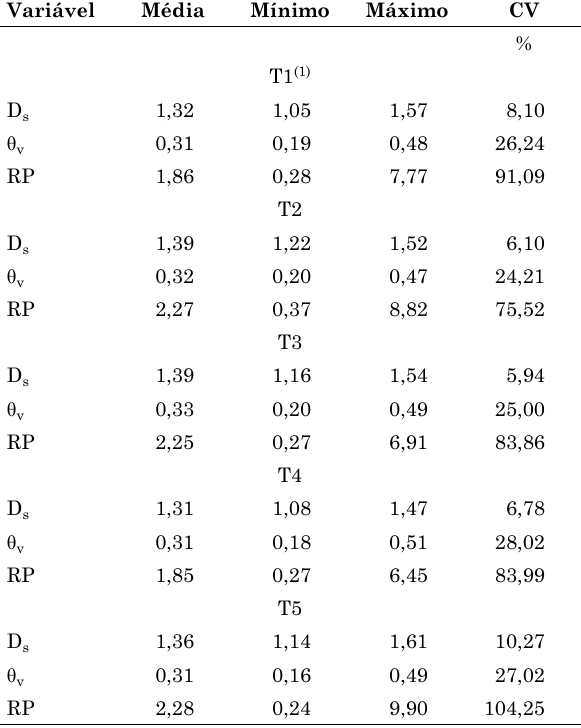
N: 56; Ds: densidade do solo (kg dm -3 ); θ v : conteúdo volumétrico de água (m 3 m -3 ); RP: resistência mecânica do solo à penetração (MPa); Min.: valor mínimo da variável; Máx.: valor máximo da variável; CV: coeficiente de variação. (1) T1: solo construído cultivado com Hemarthria altissima ; T2: solo construído cultivado com Paspalum notatum ; T3: solo construído cultivado com Cynodon dactilon ; T4: solo construído cultivado com Urochloa brizantha ; e T5: solo construído sem a implantação de plantas de